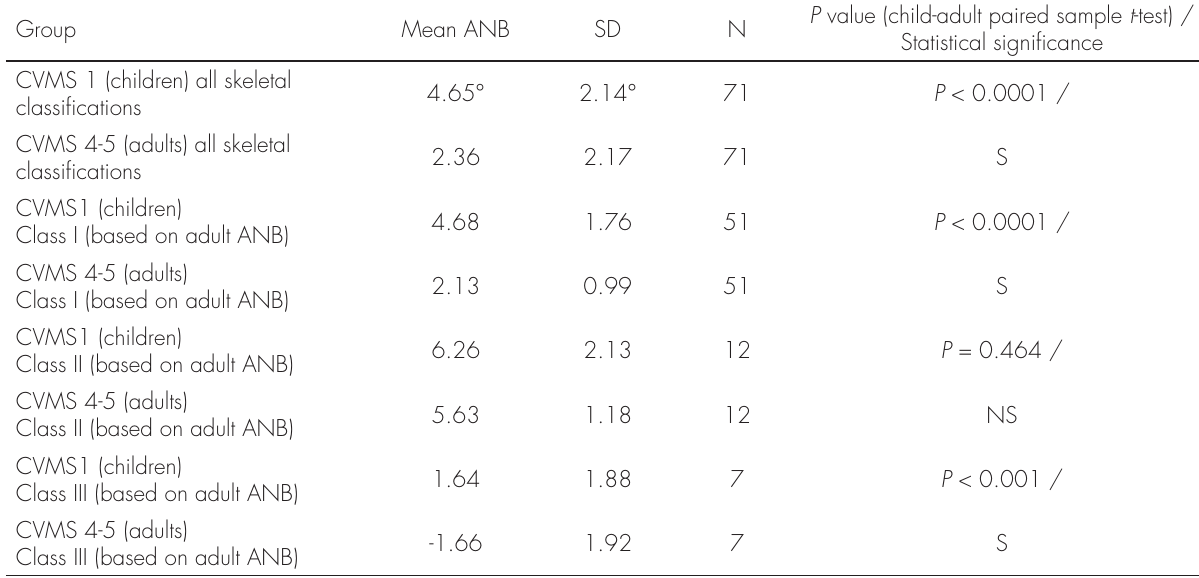
*One male subject with an adult skeletal Class I relationship was eliminated from this group due to a dental Class II